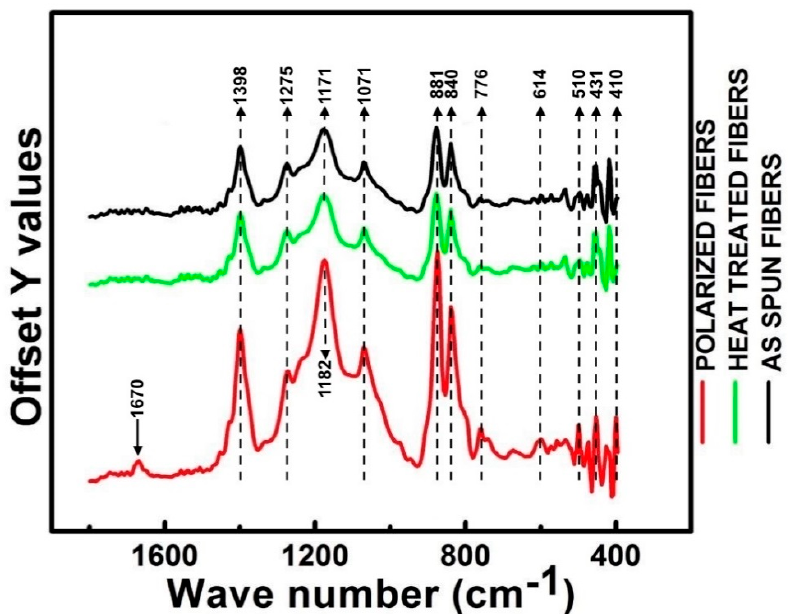
Figure 6. A comparison of FTIR spectra profiles in the fingerprint region between 400–1800 cm − 1 .